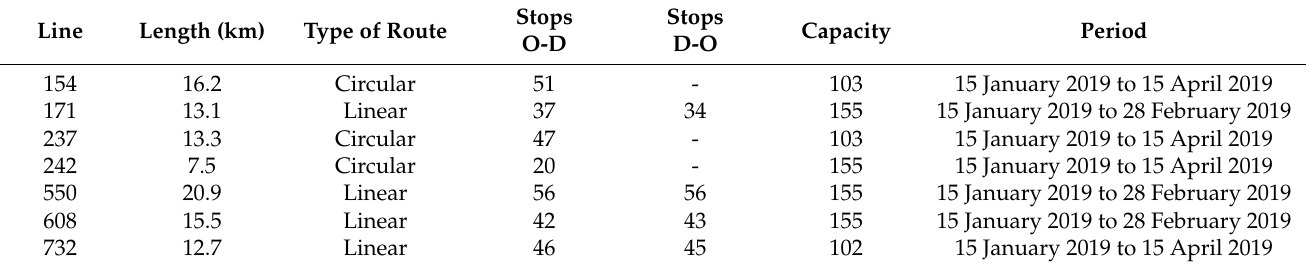
Table 2. Characteristics of bus